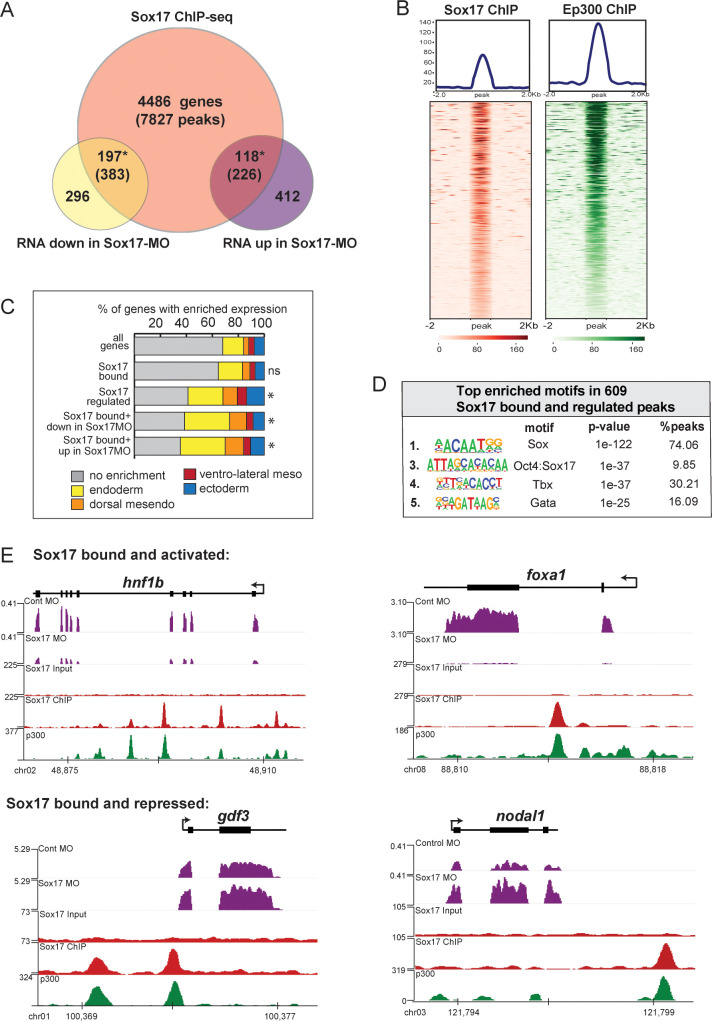
ChIP-seq identifies Sox17-bound enhancers and direct transcriptional targets.Sox17 ChIP-seq of gastrula embryos. (A) Venn diagram of Sox17-bound genes (and associated peaks) from ChIP-seq intersected with Sox17-regulated genes. Gene intersections are statistically significant based on hypergeometric tests* p<0.001. (B) Peak density plots showing that the Sox17-bound loci are cobound by the histone acetyltransferase Ep300, a marker of active enhancers. Average density of all peaks in top panel. (C) Sox17-bound genes are enriched in the endoderm. Stacked bar graphs showing different patterns of enriched spatial expression based on RNA-seq of dissected gastrula tissues (Blitz et al., 2017). Distribution of expression patterns statistically different from all genes in the genome was determined by two-sided KolmogorovSmirnov tests *p<0.01. (D) Top enriched DNA-binding motifs in Sox17 peaks, based on HOMER hypergeometric test. (E) Genome browser views of representative genes showing RNA-seq expression in control-MO and sox17-MO embryos and ChIPseq tracks of Sox17 and Ep300 binding.